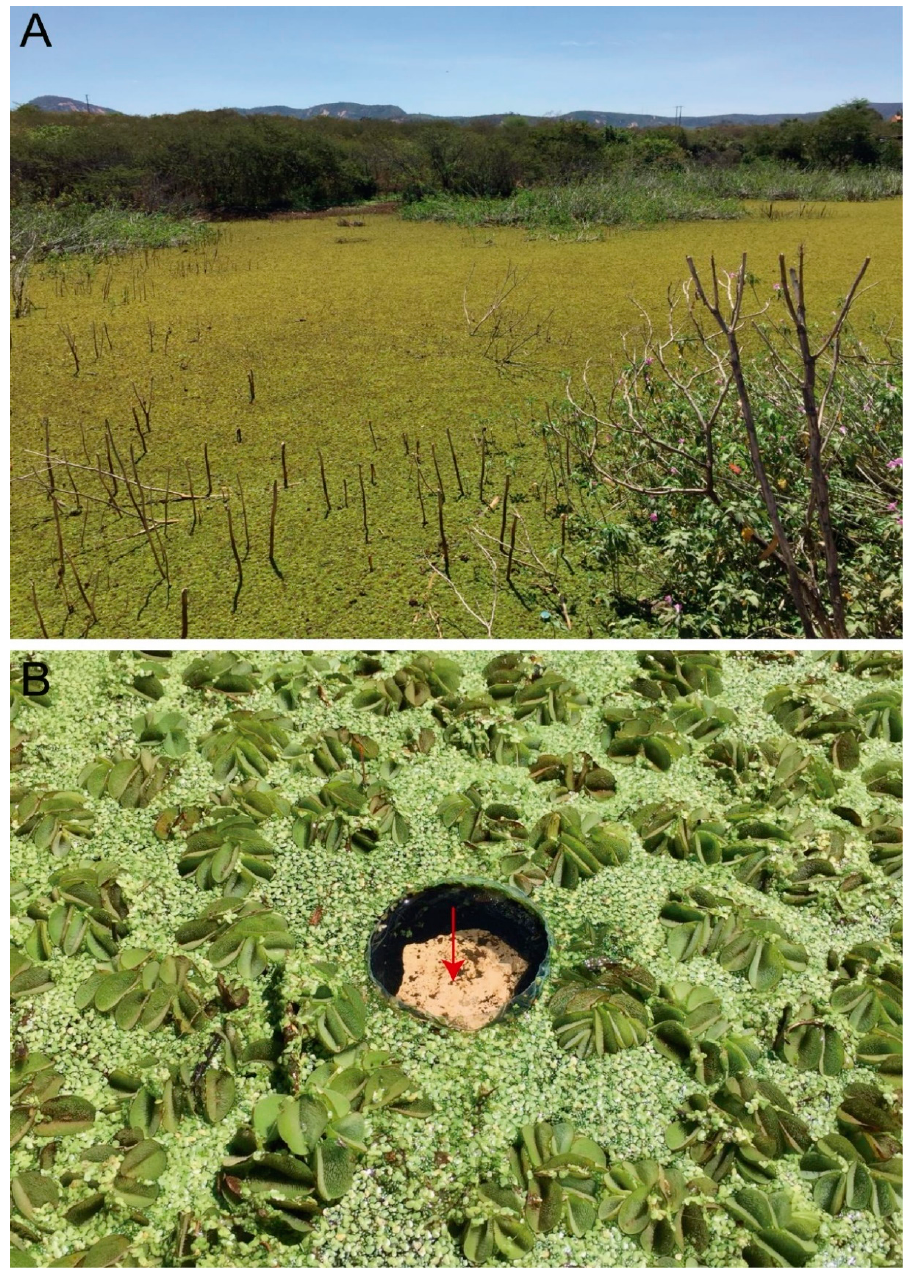
Figure 2. Habitat of the type locality of Arlesminthurus caatinguensis sp. nov.: ( A ) shallow wa-ters covered by macrophytes in Catolé do Rocha municipality, Paraíba State, Brazil; ( B ) pit-fall-traps on the water surface among Salvinia auriculata, Lemna minor and Wolffia sp.; red arrow indicates the stone inside the trap.